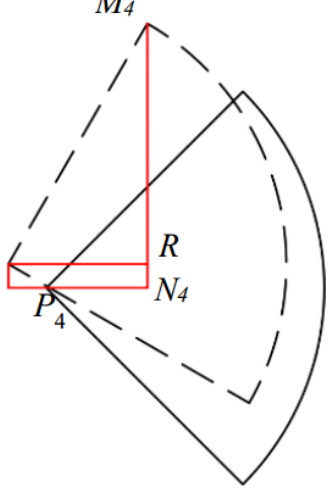
Figure 8. Two reachable area of leg 4 before (solid line) and after (dash line) trunk twisting.